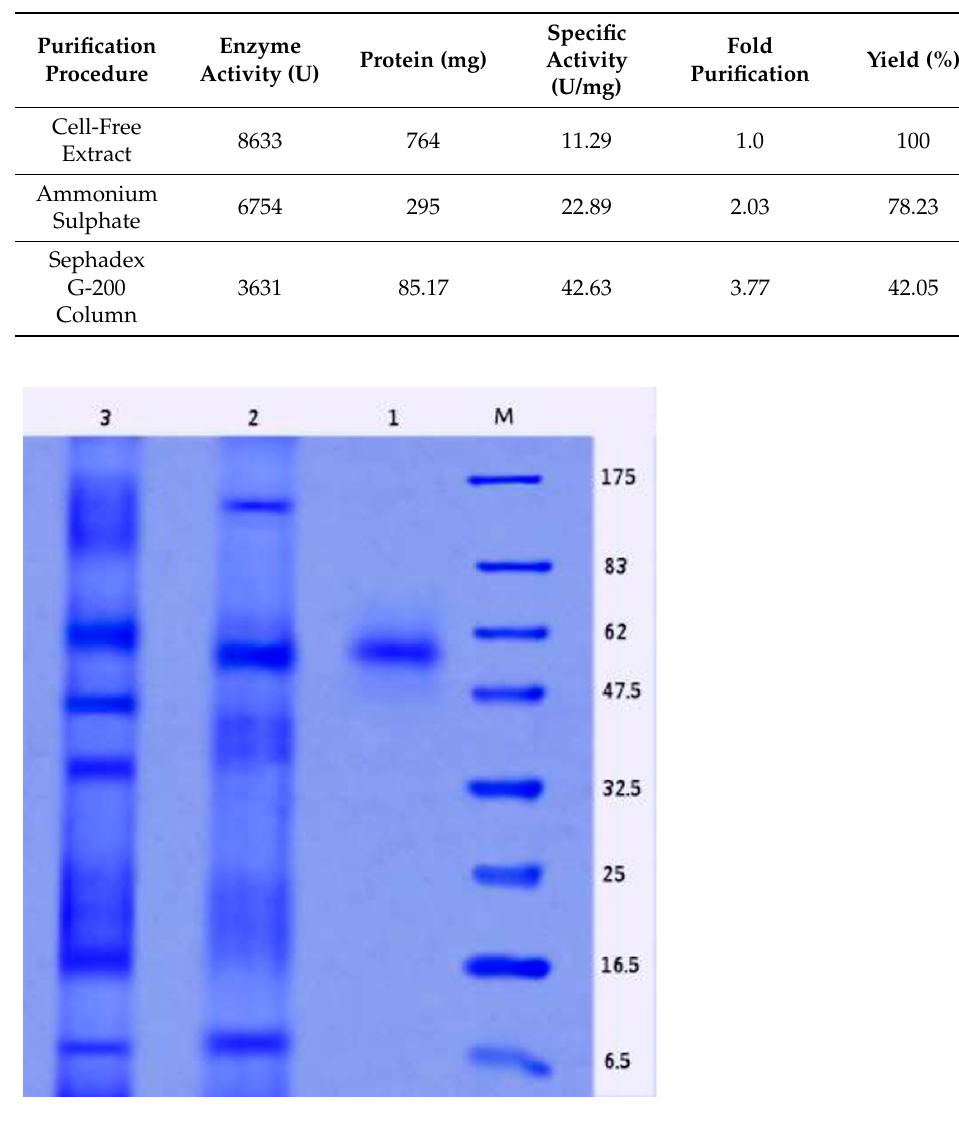
Table 1. Purification procedure of crude L-glutaminase from Halomonas meridiana.